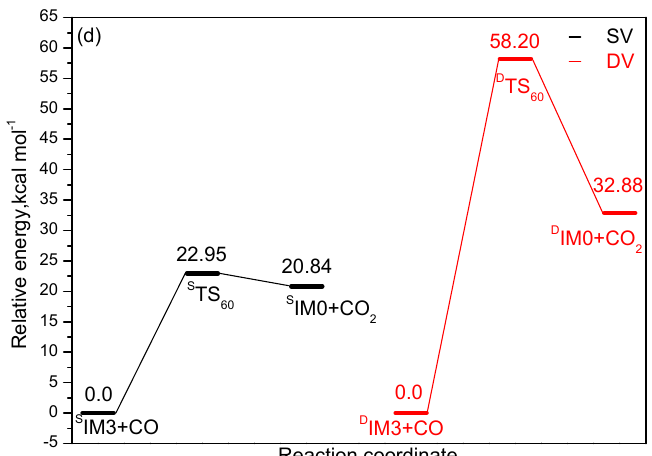
Figure 5. Energy profiles for the reactions of ( a ) O 2 activation; ( b ) CO oxidation over W-SV-graphene; ( c ) CO oxidation over W-DV-graphene; ( d ) CO oxidation on W-embedded graphene by Oads.